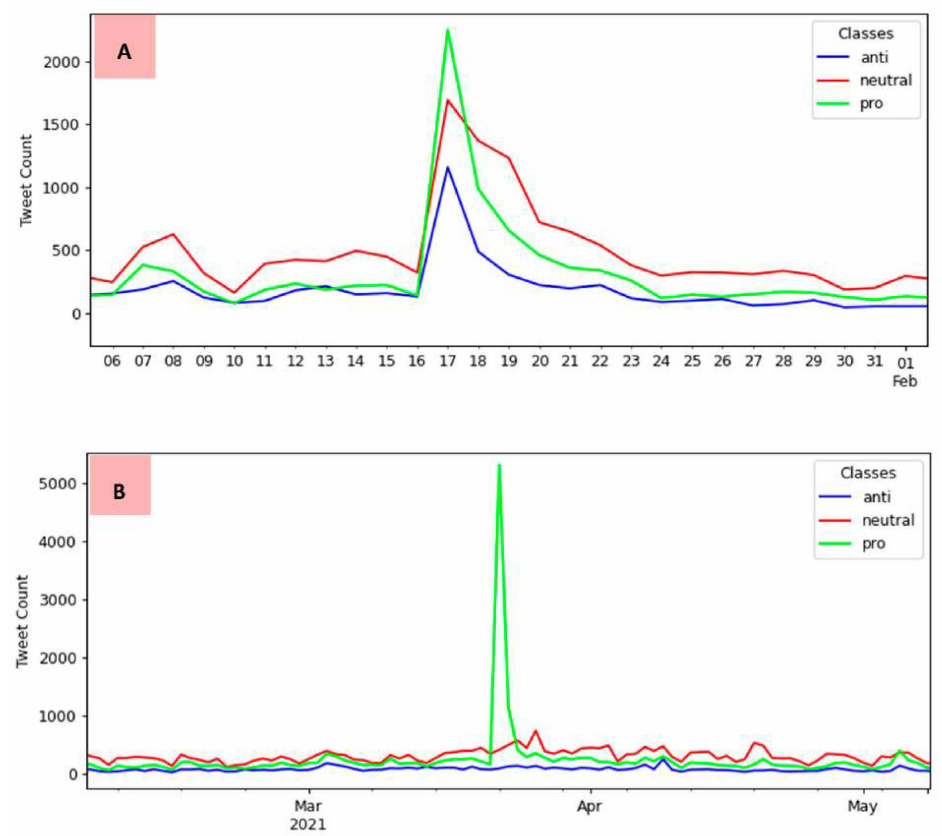
Figure 8. Details of the peaks: ( A ) refers to the first interval peak and ( B ) to the second interval